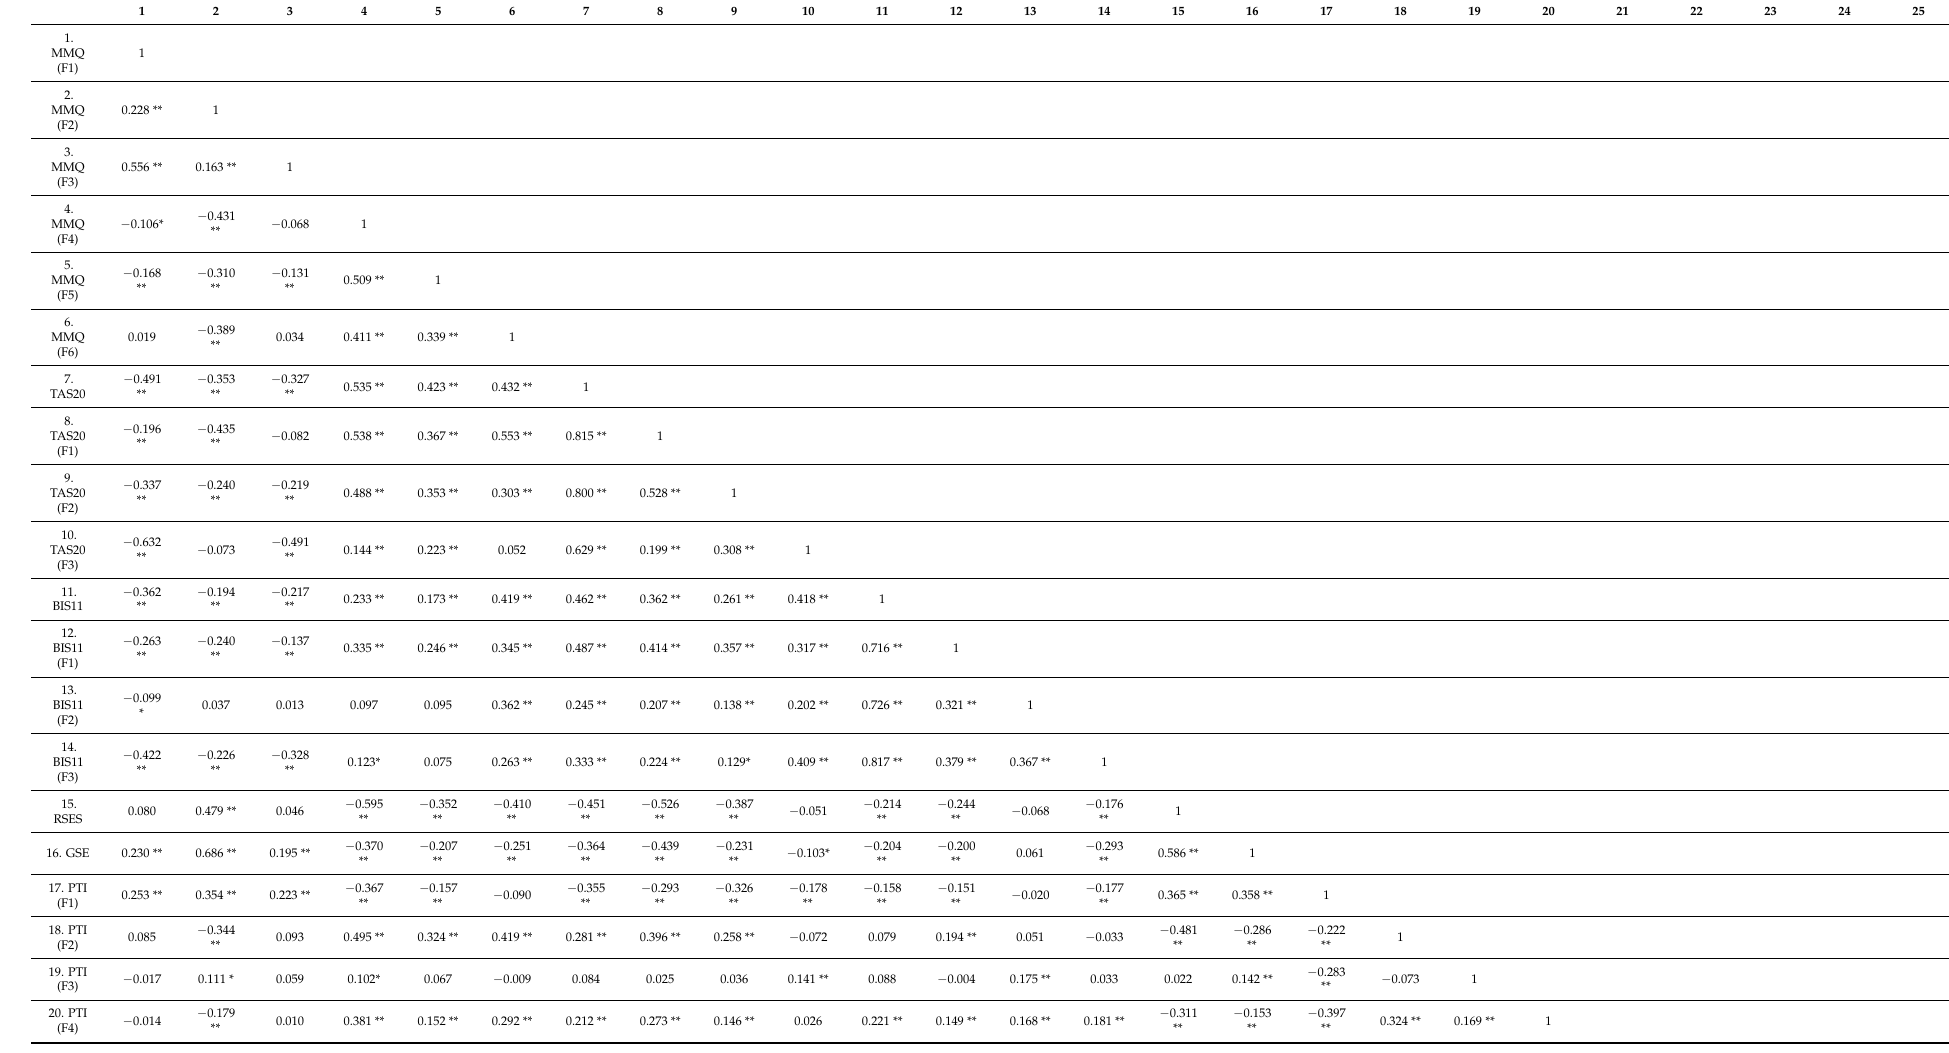
Table 4. Correlation